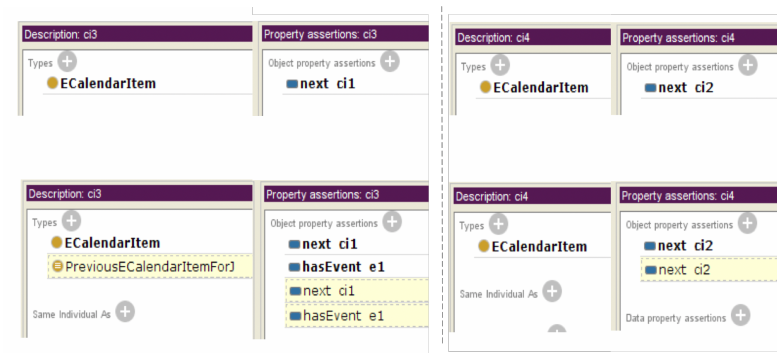
Figure 8. e-calendar items c 3 and c 4. Top of the figure depicts the two individuals before the reasoning process, the bottom depicts the result of the reasoning